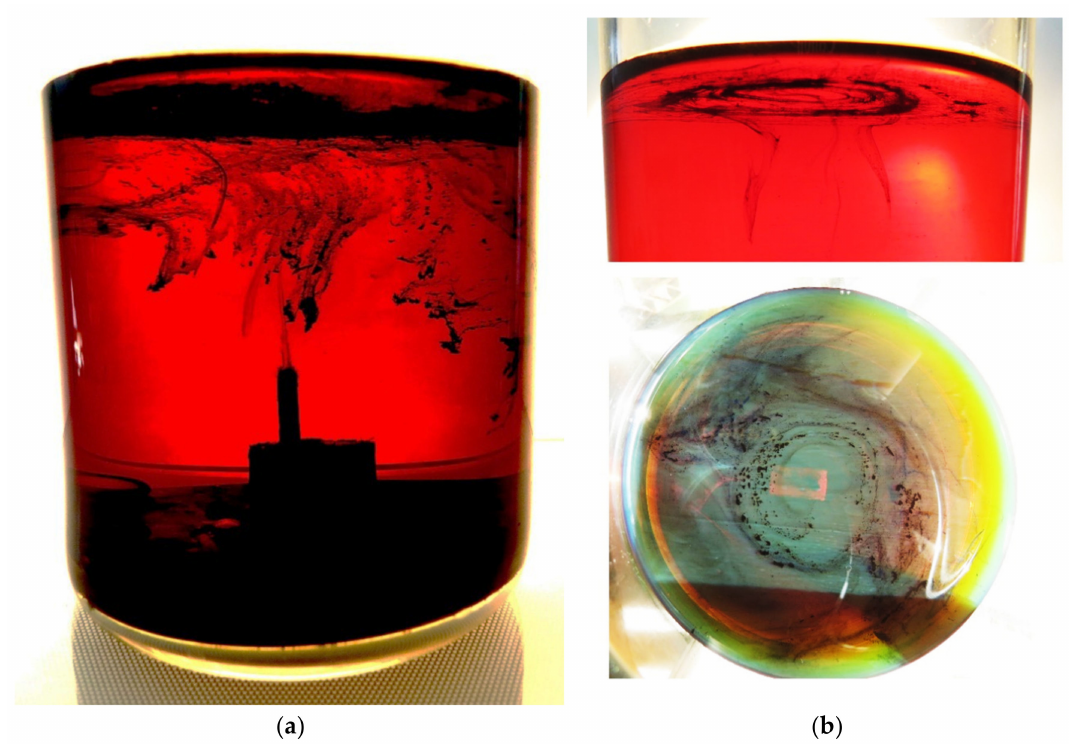
Figure 7. Snapshot of traces of carbonaceous particles in the engine oil just after switching-off the microwave discharge ( a ); and view of vortex structure creating by solid particles ( b